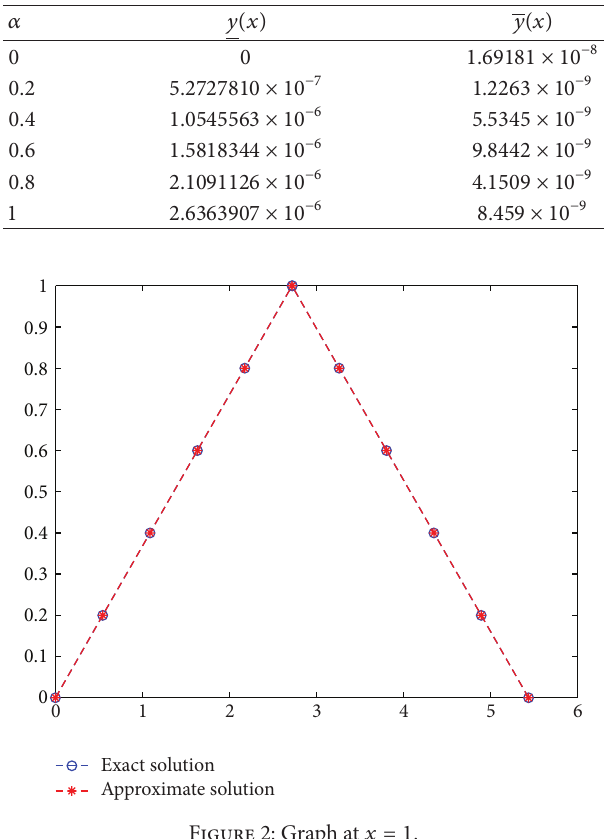
Table 3: Error estimation.